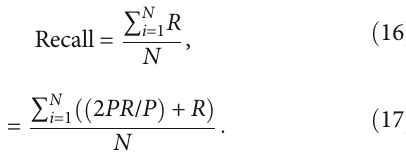
Figure 4: Long-short-term memory network.